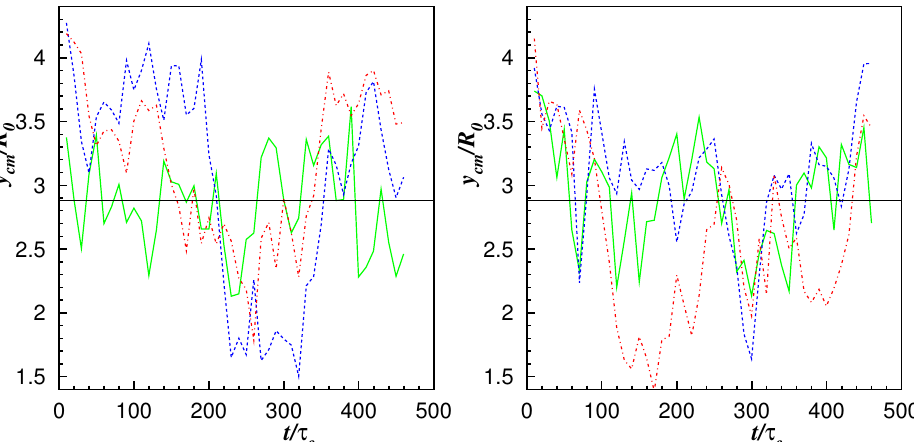
Figure 9. Time behavior of the vertical position y cm of the vesicle center of mass (values are sampled every 10 τ c ) at S ∗ = 0.80 ( left ) and S ∗ = 0.95 ( right ) for κ / ( k B TR 0 ) = 6.58 with λ = 1 (full green line), 7 (dashed blue line), 15 (dot-dashed red line). The horizontal full line denotes the center of the